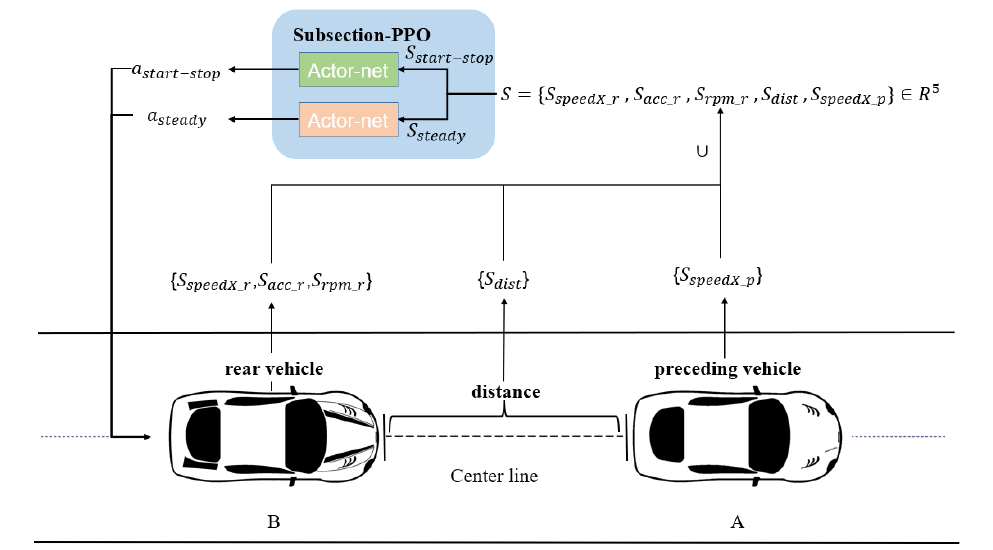
Figure 1. Vehicle-following